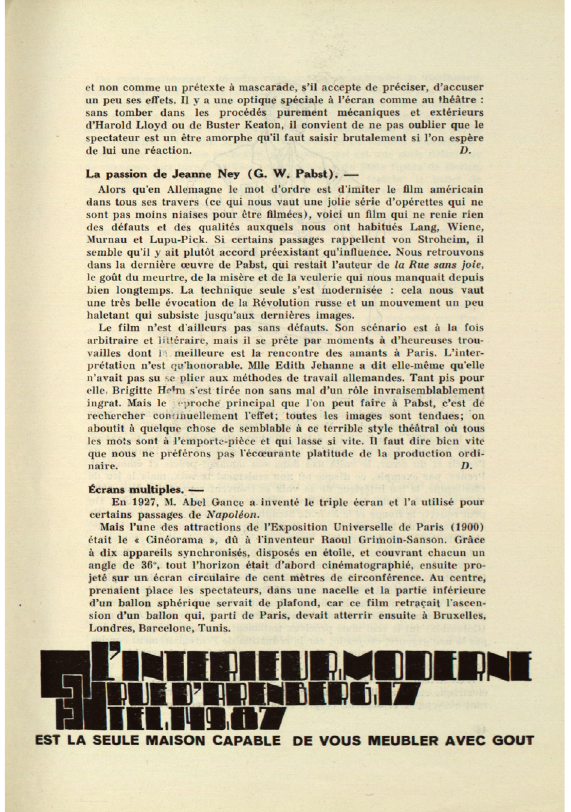
Fig. 13. Advertisement for ‘L’intérieur moderne’, Variétés , no. 1 (15 May 1928),